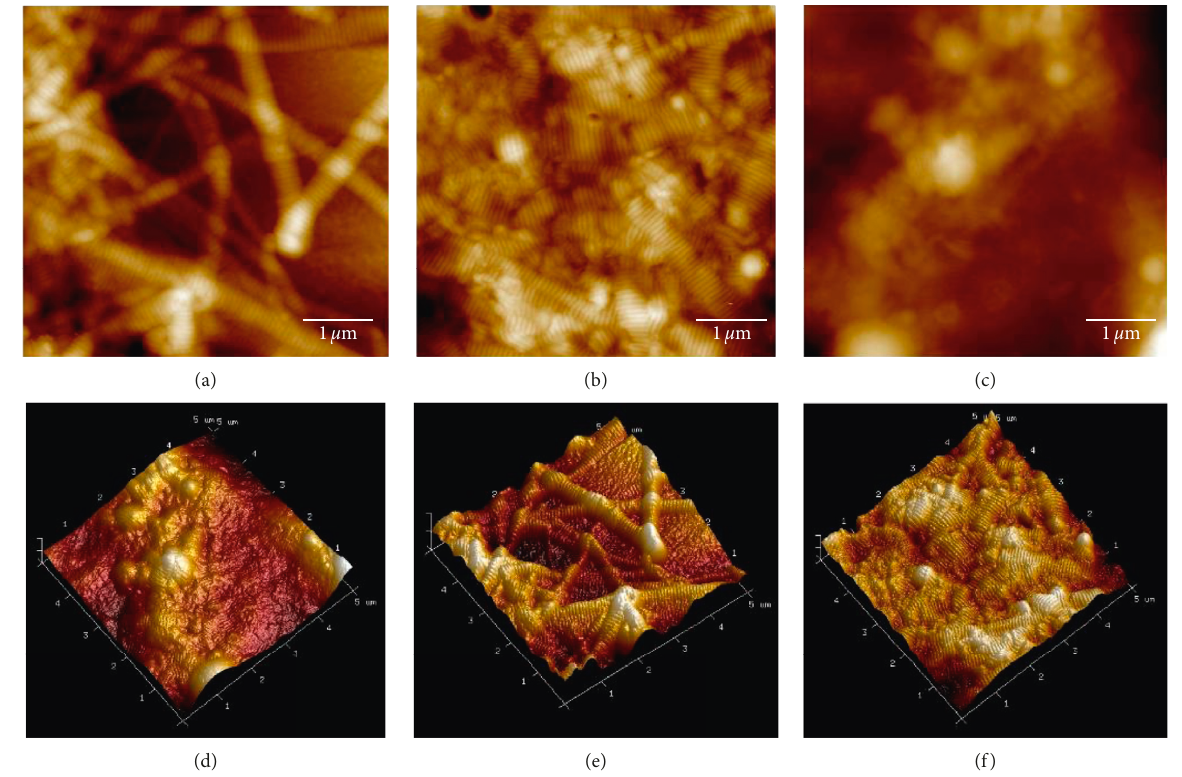
Figure 8: Typical AFM height 2D (upper) and 3D (lower) images of collagen fibrils treated by acid-base soaking. (a–c) Samples soaked in acid solutions at pH 3 for 7.5, 15, and 25h, respectively; (d–f) 3D images of (a–c), respectively.